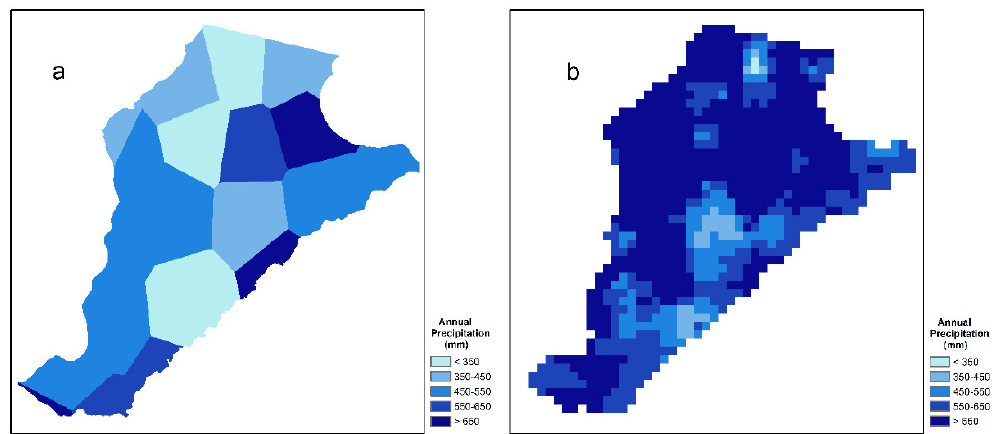
Figure 10. Spatial distribution of annual precipitation of Haihe Plain in 2006 ( a ) using precipitation based on rain gauge data; ( b ) using precipitation based on remote sensing data.